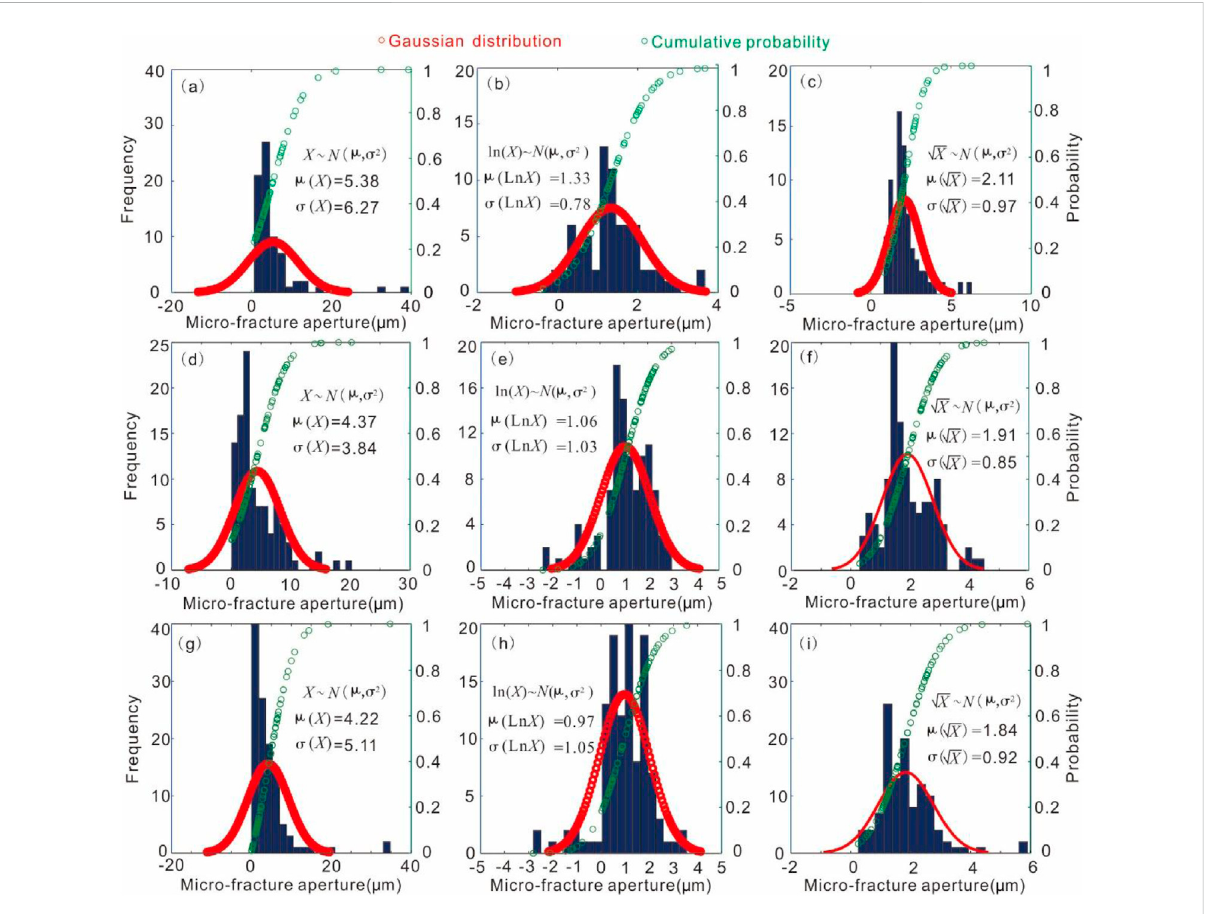
FIGURE 11 Micro-fractureaperture distribution for thecoalswith differentranks: (A – C) , low-ranking coal; (D – F) ,middle-rankingcoal; (G – I) ,high-ranking